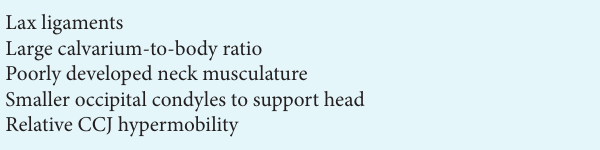
Table 1. Factors predisposing to childhood CCJ injury Lax ligaments Large calvarium-to-body ratio Poorly developed neck musculature Smaller occipital condyles to support head Relative CCJ